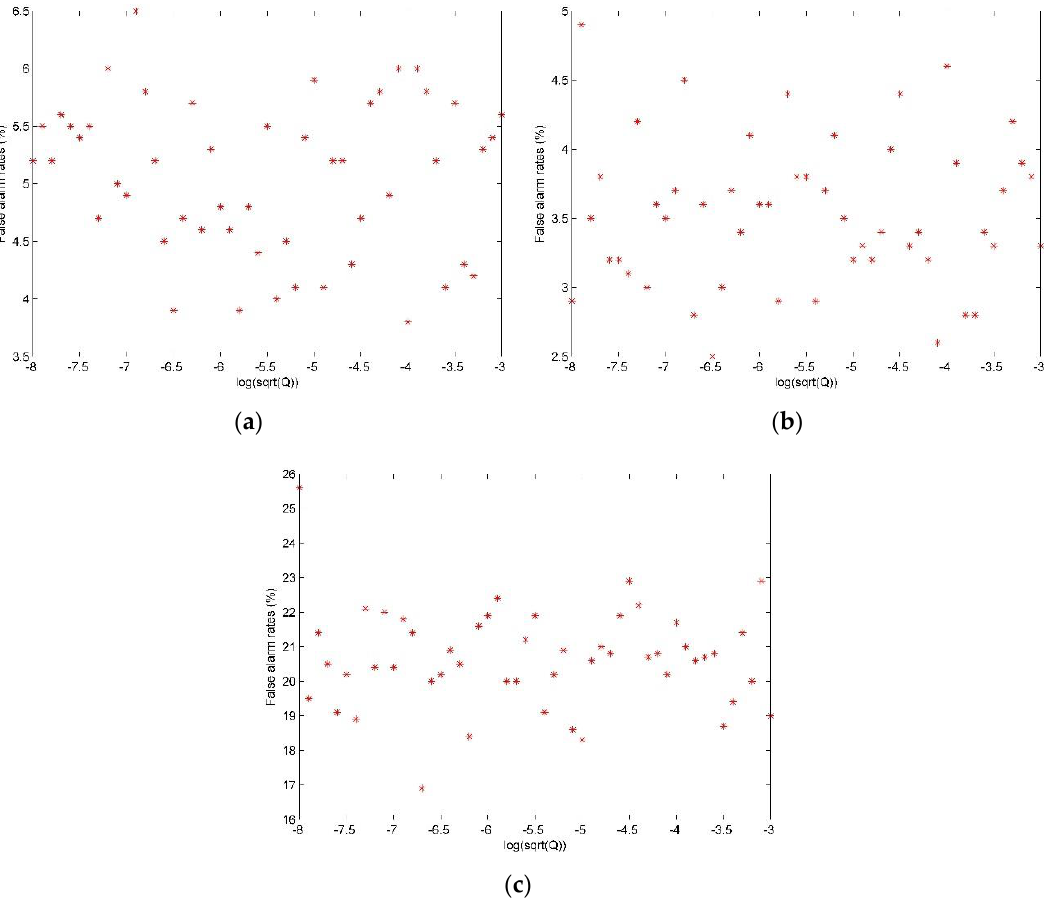
Figure 11. False alarm rates test: ( a ) blending filter solution false alarm rates test by T D ; ( b ) blending filter solution false alarm rates test by correction T D ; ( c ) extended Kalman filter solution false alarm rates test by correction T D .